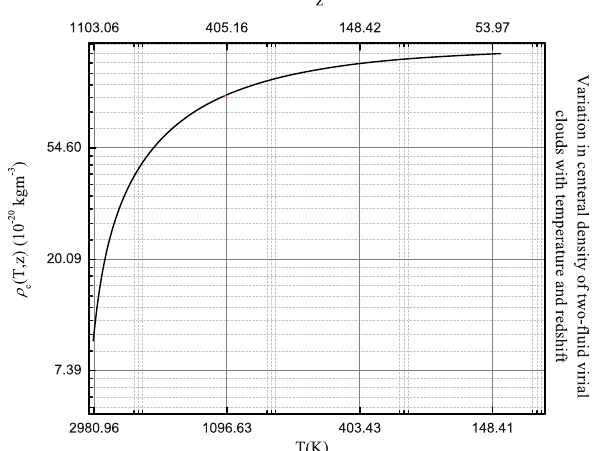
Fig. 4 Variation in the central density of the virial clouds made up by a mixture of H and He with cosmological primordial relative abundances